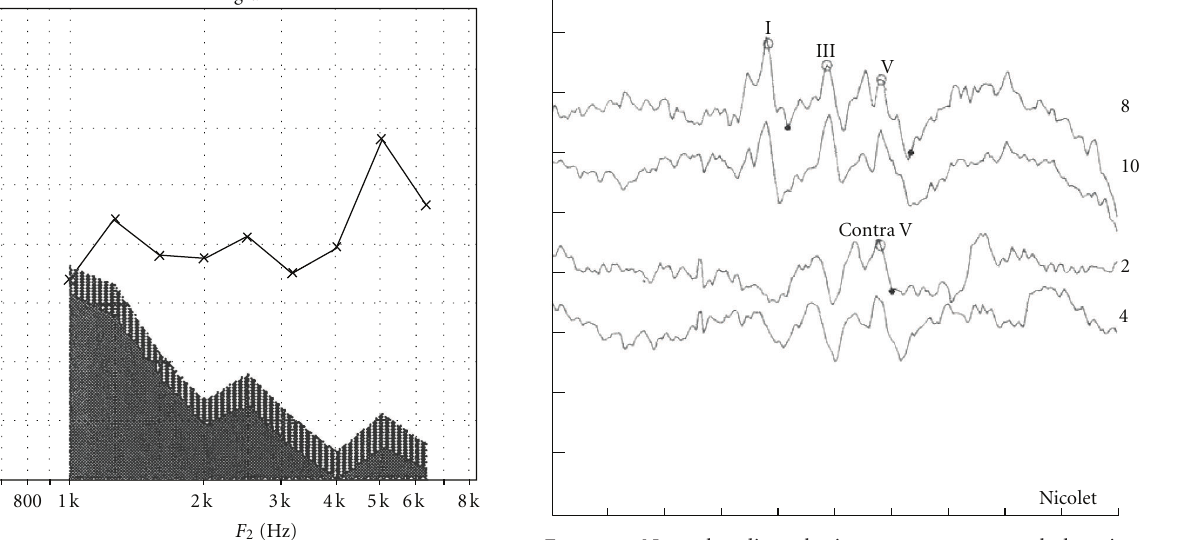
Figure 5: Distortion product otoacoustic emissions in a patient with brainstem pathology secondary to closed head injury for stimulation of the left ear.